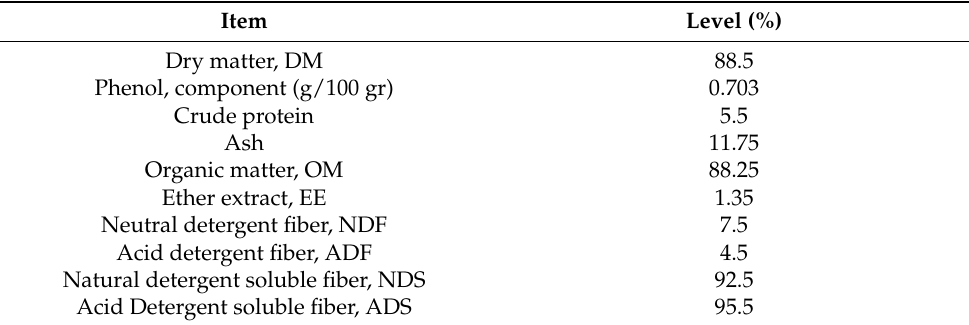
Table 2. Nutrient composition of ginger powder (% DM) used in the